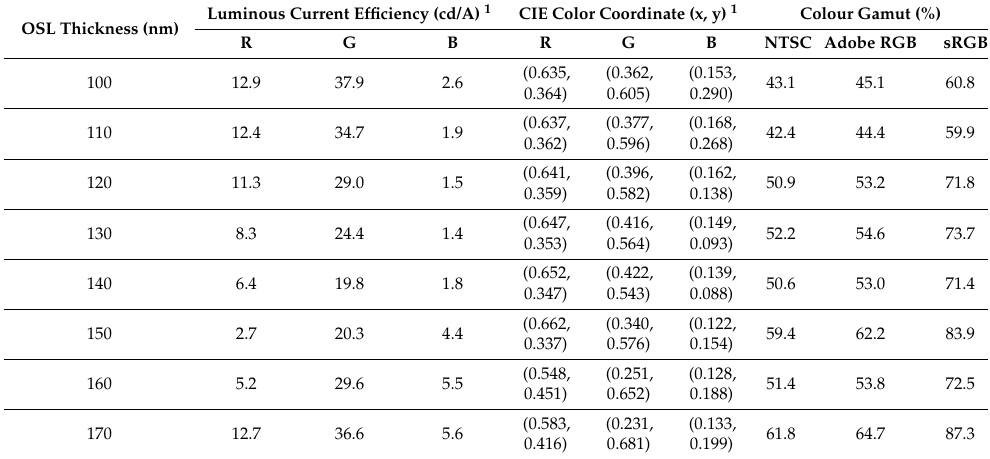
Table 1. Performance of the R, G, and B devices with micro-cavity structure embedded cathodes depending on OSL thicknesses.